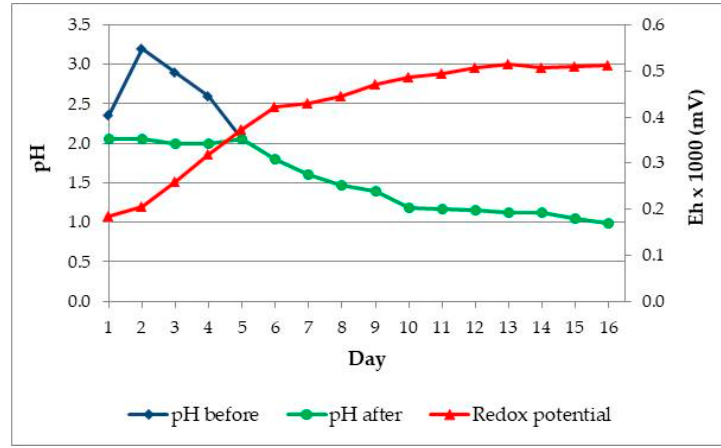
Figure 2. Changes in pH and Eh (mV) vs. time in Adaptation I. Black circles—pH before H 2 SO 4 addition; blue squares—pH after H 2 SO 4 addition; red triangles—Eh (mV).